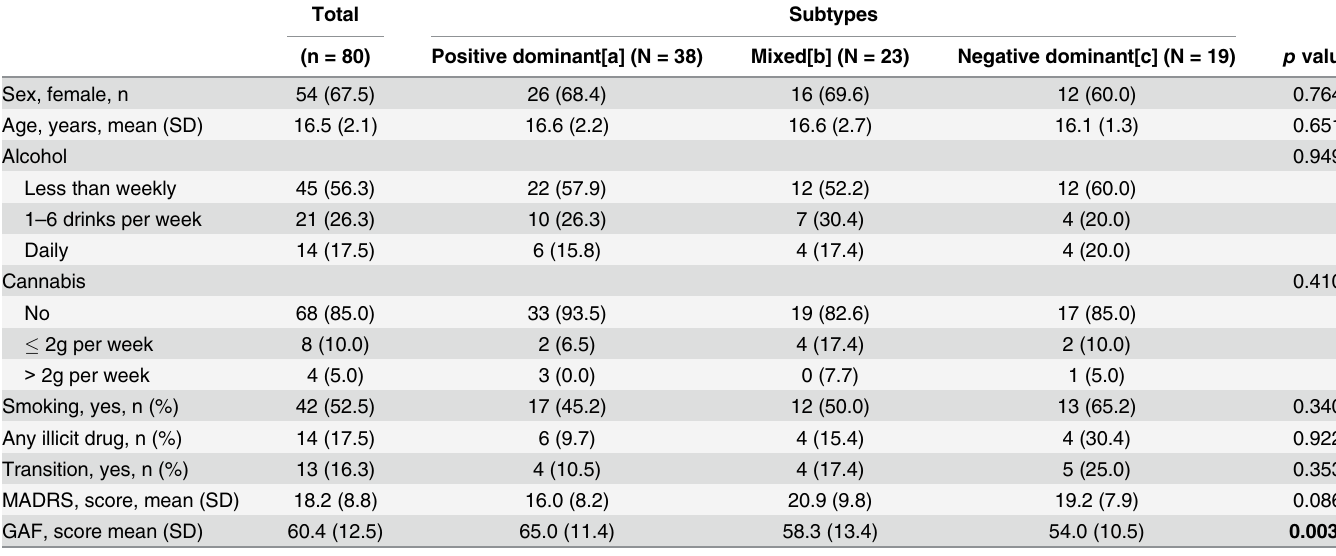
Table 2. Comparison of demographic and clinical characteristics of participants according to dominance of positive or negative